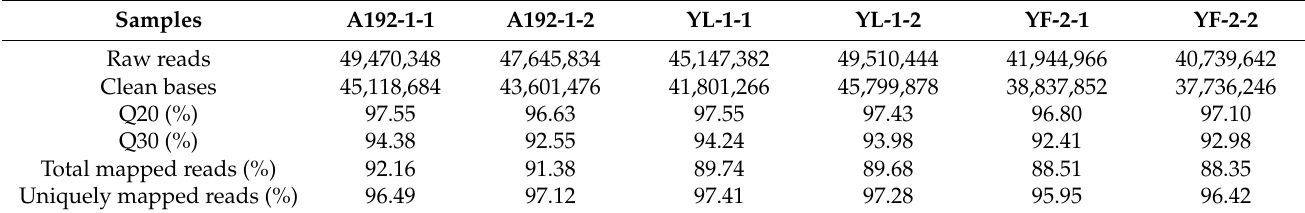
Table 1. Overview of the transcriptome sequencing dataset.